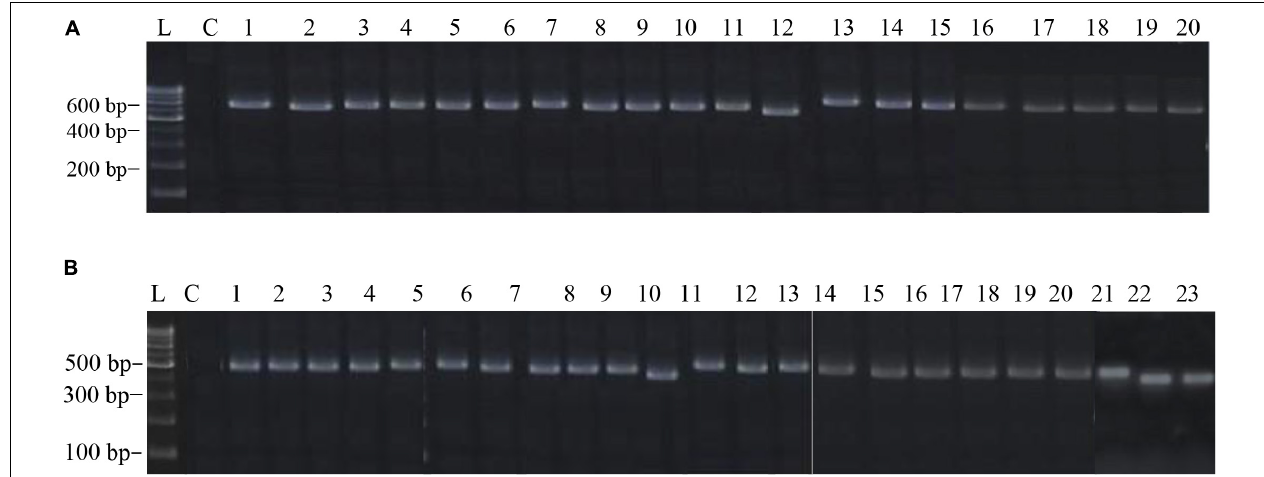
FIGURE 6 | (A) The electrophoretogram shows the positive PCR amplification of Aspergillus ITS genes with species-specific amplicons. Here, L, 100-bp MBT049 HIMEDIA DNA ladder; C, PCR with a negative control; 1, 49- Aspergillus nidulans ; 2, 58- Aspergillus nidulans ; 3, 63- Aspergillus tamarii ; 4, 31- Aspergillus fumigatus ; 5, 37- Aspergillus fumigatus ; 6, 45- Aspergillus nidulans ; 7, 51- Aspergillus terreus ; 8, 52- Aspergillus terreus ; 9, 71- Aspergillus nidulans ; 10, 75- Aspergillus tamarii ; 11, 83- Aspergillus sydowii ; 12, 17- Aspergillus miyajii ; 13, 16- Aspergillus terreus ; 14, 22- Aspergillus tamarii ; 15, 29- Aspergillus sp.; 16, 4- Aspergillus quadrilineatus ; 17, 2- Aspergillus rugulosus ; 18, 1- Aspergillus terreus ; 19, 11- Aspergillus nidulans ; 20, 12- Aspergillus nidulans . (B) The electrophoretogram shows the positive PCR amplification of Aspergillus β -tubulin genes with species-specific amplicons. Here, L, 100-bp MBT049 HIMEDIA DNA ladder; C, PCR with a negative control; 1, 49- Emericella quadrilineata ; 2, 58- Emericella quadrilineata ; 3, 61- Aspergillus flavus ; 4, 31- Aspergillus fumigatus ; 5, 37- Aspergillus fumigatus ; 6, 45- Aspergillus nidulans ; 7, 51- Aspergillus aureoterreus ; 8, 71- Aspergillus nidulans ; 9, 75- Aspergillus tamarii ; 10, 18- Aspergillus aureoterreus ; 11, 17- Aspergillus nidulans ; 12, 16- Aspergillus terreus ; 13, 9- Aspergillus nidulans ; 14, 24- Aspergillus fumigatus ; 15, 22- Aspergillus tamarii; 16, 4- Aspergillus latus ; 17, 2- Emericella nidulans ; 18, 1- Aspergillus aureoterreus ; 19, 11- Aspergillus latus ; 20, 12- Aspergillus latus ; 21, S8- Aspergillus awamori ; 22, S24- Aspergillus awamori ; 23, S44- Aspergillus tamarii